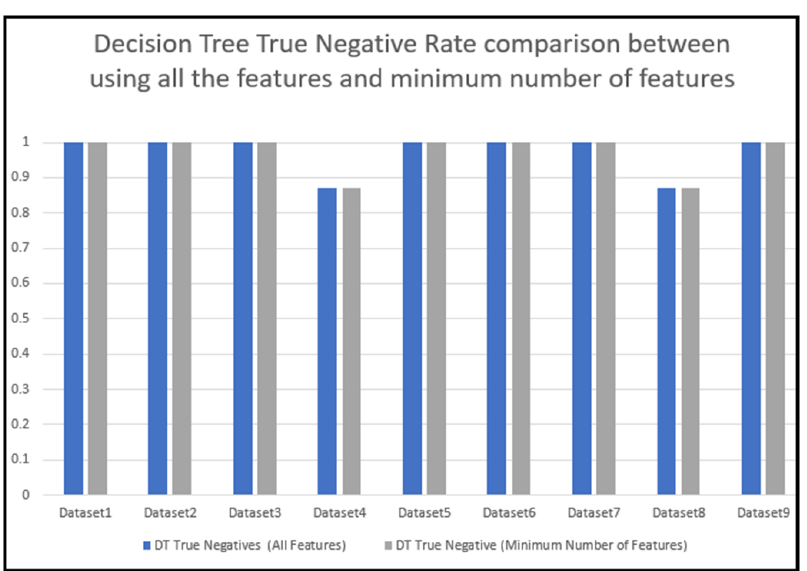
Figure 12. DT benign communication prediction results compared between using the minimum number of features and all the features in Feature set1.